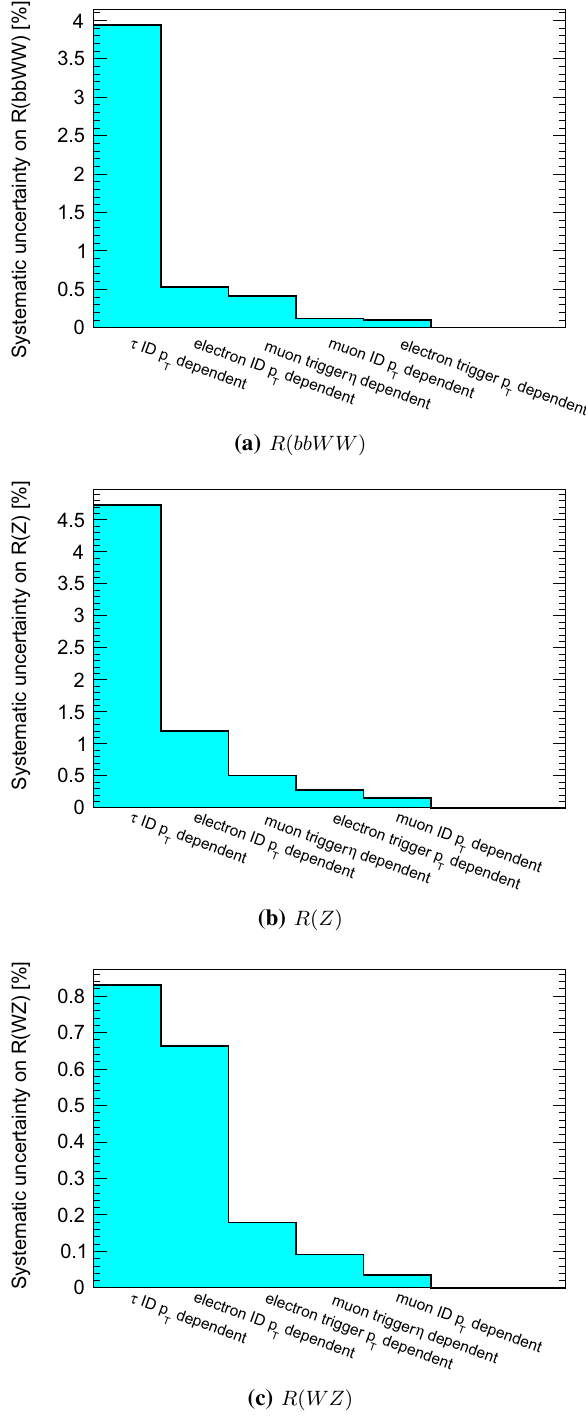
Fig. 9 Summary of the most significant changes in the ratios a R ( bbWW ) , b R ( Z ) , and c R ( W Z ) arising from sources of p T / η - dependent systematic uncertainty. From left to right in each sub-figure the sources are ordered in descending magnitude of the resulting sys- tematic uncertainty